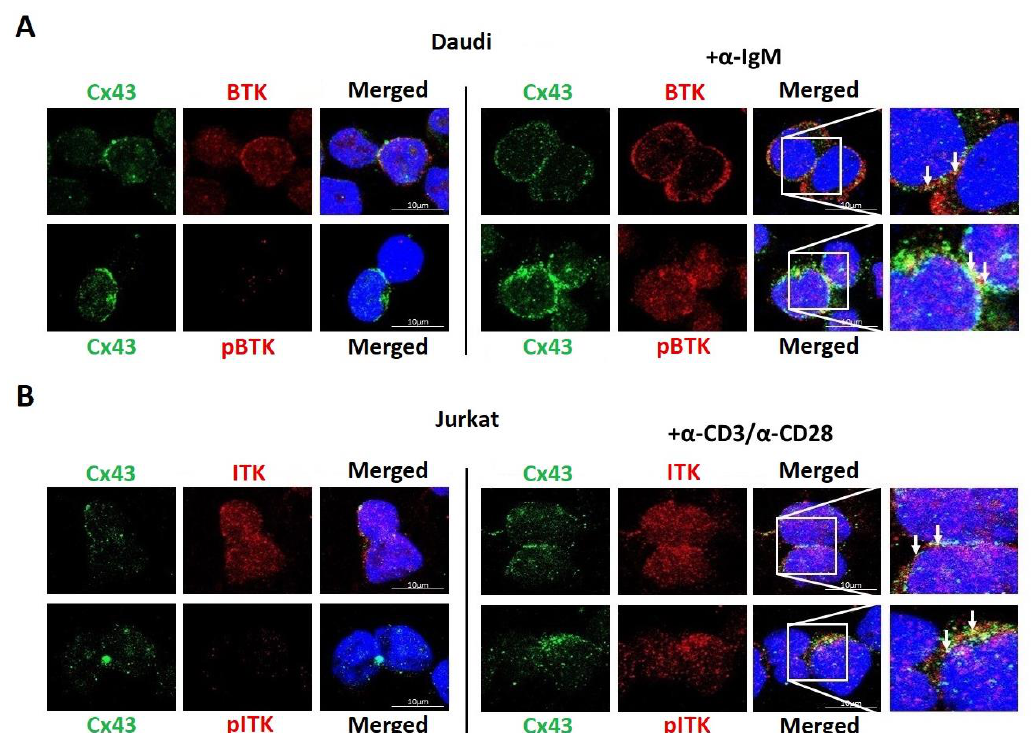
Figure 8. Cellular localization of endogenous Cx43 in lymphocytes with active BTK or ITK. Immunofluorescence was performed to visualize Cx43 in ( A ) Daudi cells with and without BTK activation using the α -IgM antibody or ( B ) Jurkat cells with and without ITK activation using the α -CD3/ α -CD28 antibodies (Green, Cx43; Red, BTK/pBTK or ITK/pITK; Blue, DAPI; white arrows show colocalization with Cx43).